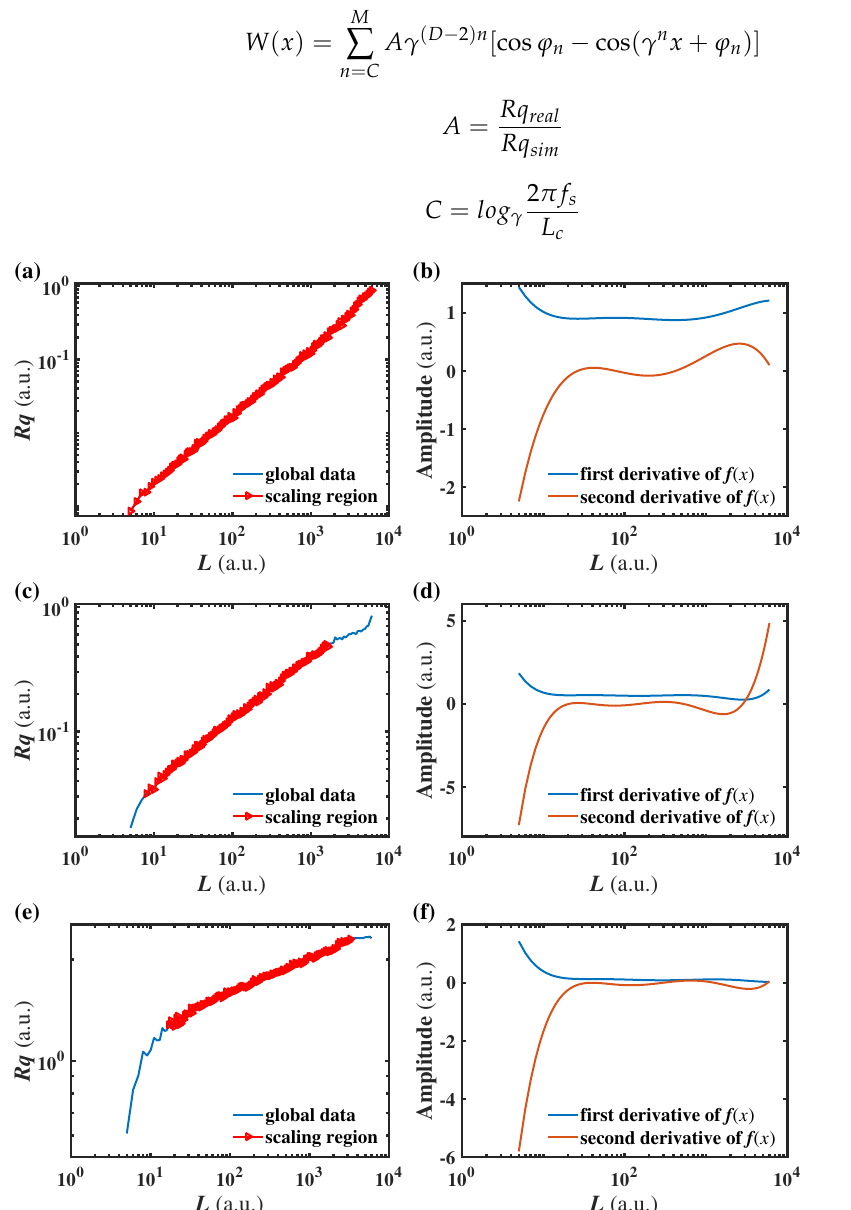
Figure 5. The typical Rq - L curves obtained by the RSE algorithm with 2-order flattening and sampling length of 6000 and the corresponding derivatives: ( a , b ) D = 1.1; ( c , d ) D = 1.5; ( e , f ) D = 1.9. The scaling regions obtained by the proposed scaling region interception method were plotted by using red triangle